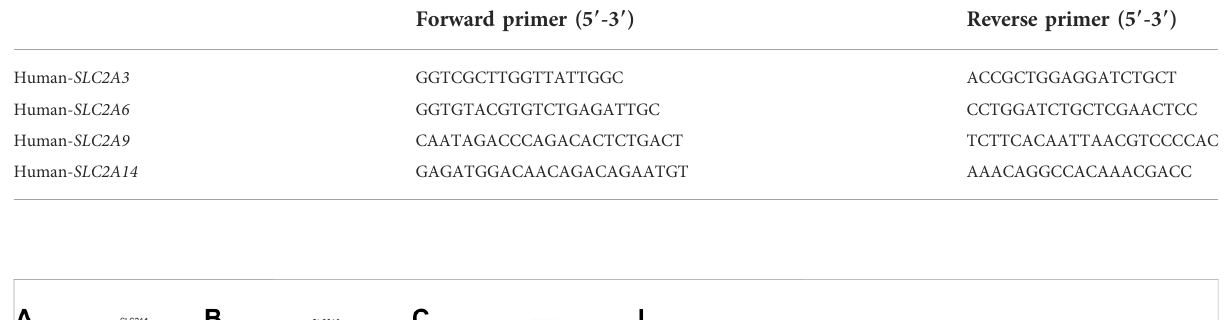
TABLE 1 The primer sequence of SLC2A3 , SLC2A6 , SLC2A9 , SLC2A14 .